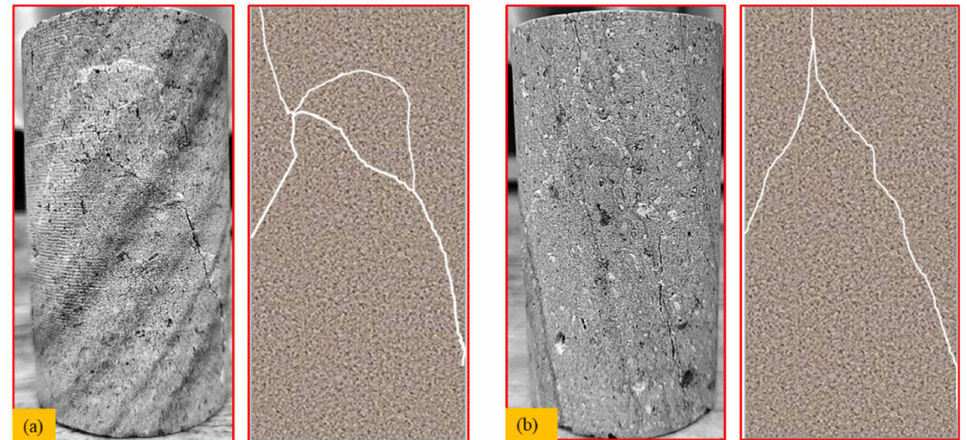
Figure 6. Specimen of failure characteristics. ( a ) Dry rock specimen after failure, ( b ) saturated rock specimen after failure.